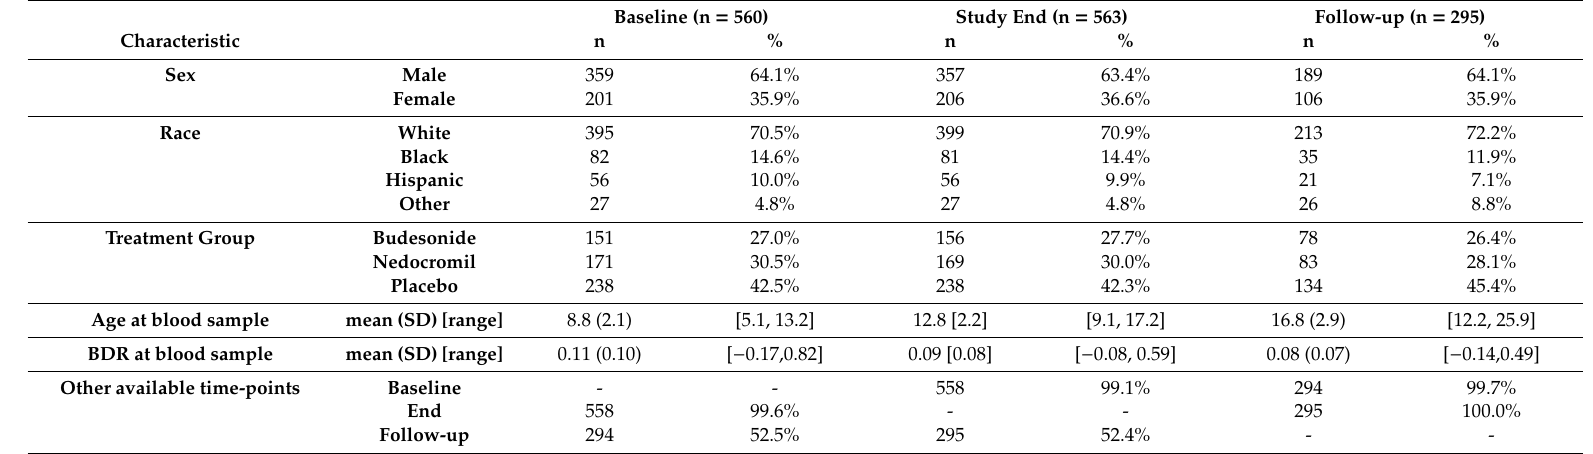
SD—Standard deviation; BDR—Bronchodilator